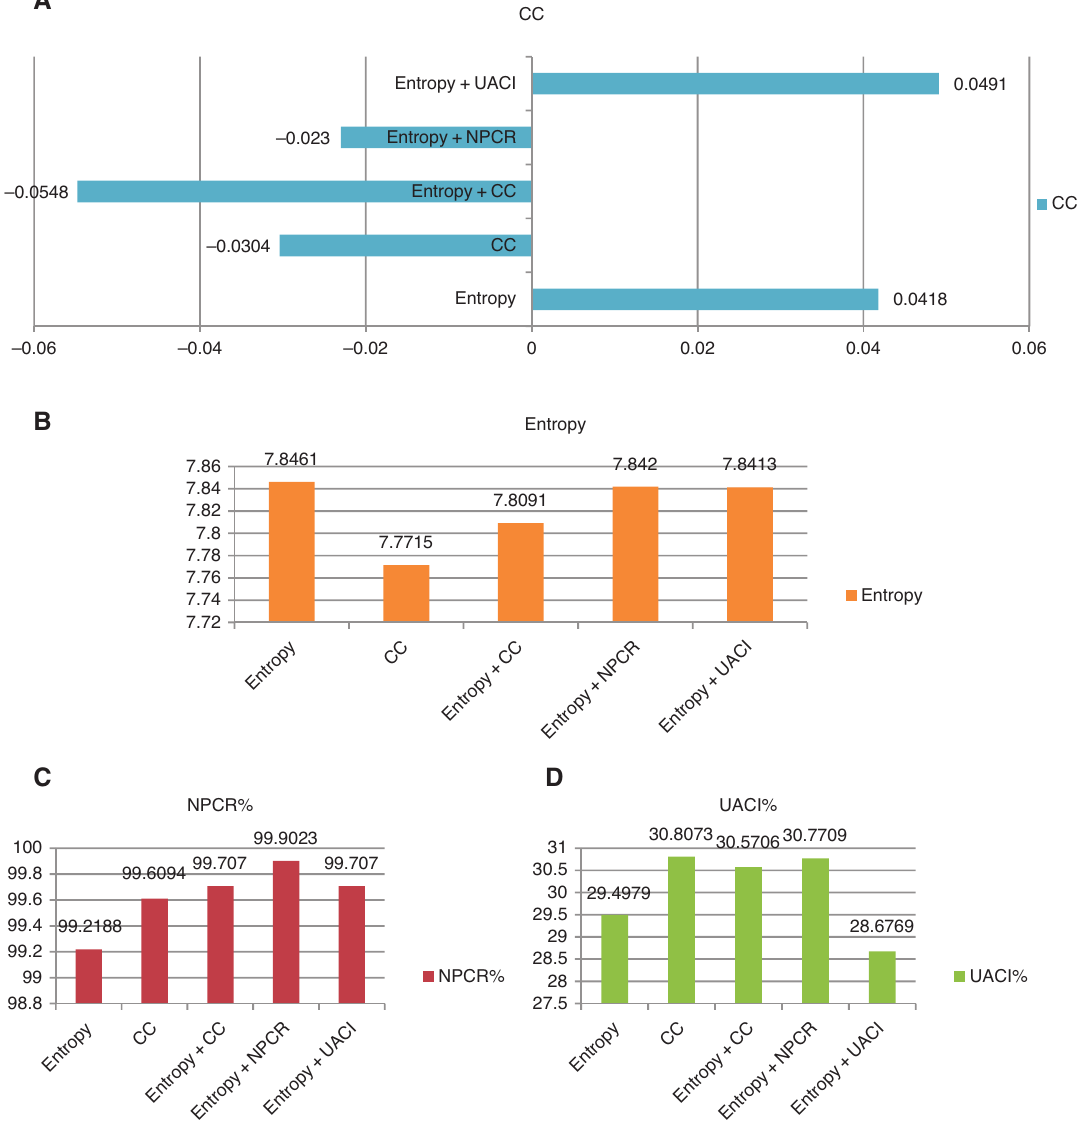
Figure 6: Comparative Analysis of Lena Image Using Logistic Map Function.